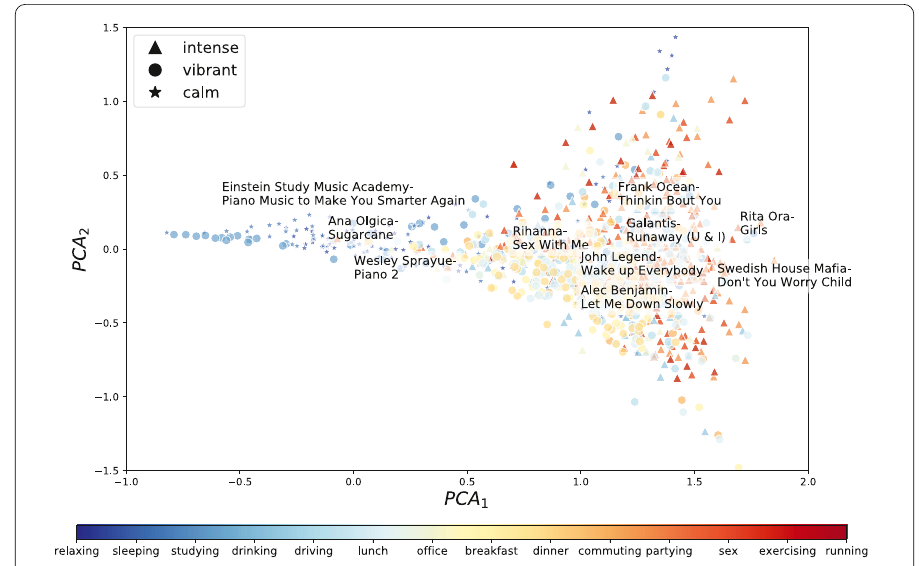
Figure 4 Projection of the songs’ feature vectors on a 2-dimensional PCA space. Individual songs are drawn with markers representing the activity group, and color-coded with their activity. Example songs close to the centroid of points for each activity are reported. Calm songs, such as those for sleeping and relaxing, are mostly located in the leftmost side of the PCA space; intense songs, such as those for exercising, sex, and partying are on the right; and vibrant songs, such as those for breakfast, lunch, dinner, and driving, are in between the calm and intense songs